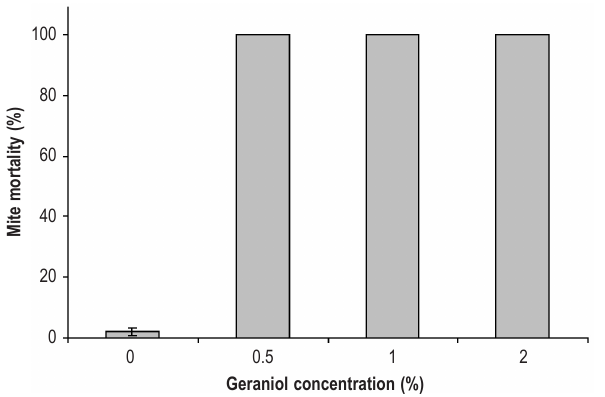
Fig. 1. – Mean percentage mortality of adult female Dermanyssus gallinae after exposure to different concentrations of geraniol over a period of 24 hours. Error bars show ± SE. N = 4 for all